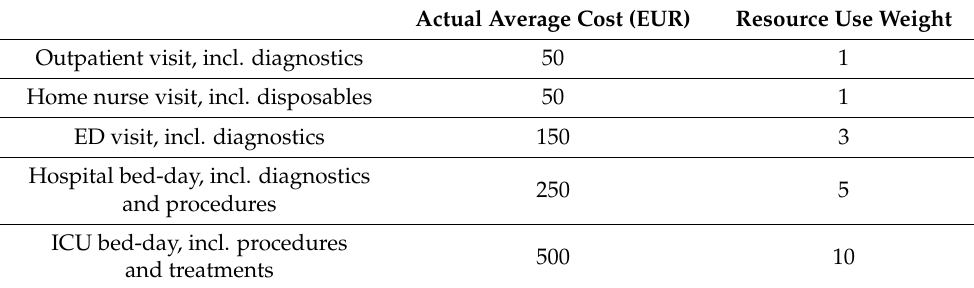
Table 5. Average cost and resource use weight of health care service at the end of life care.